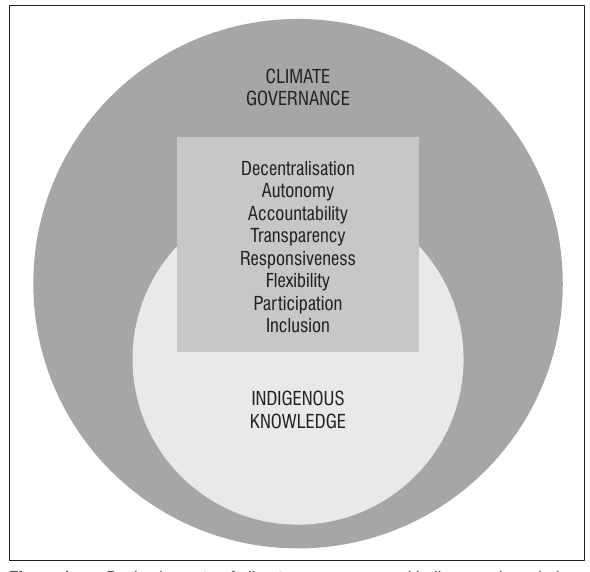
Basic elements of climate governance and indigenous